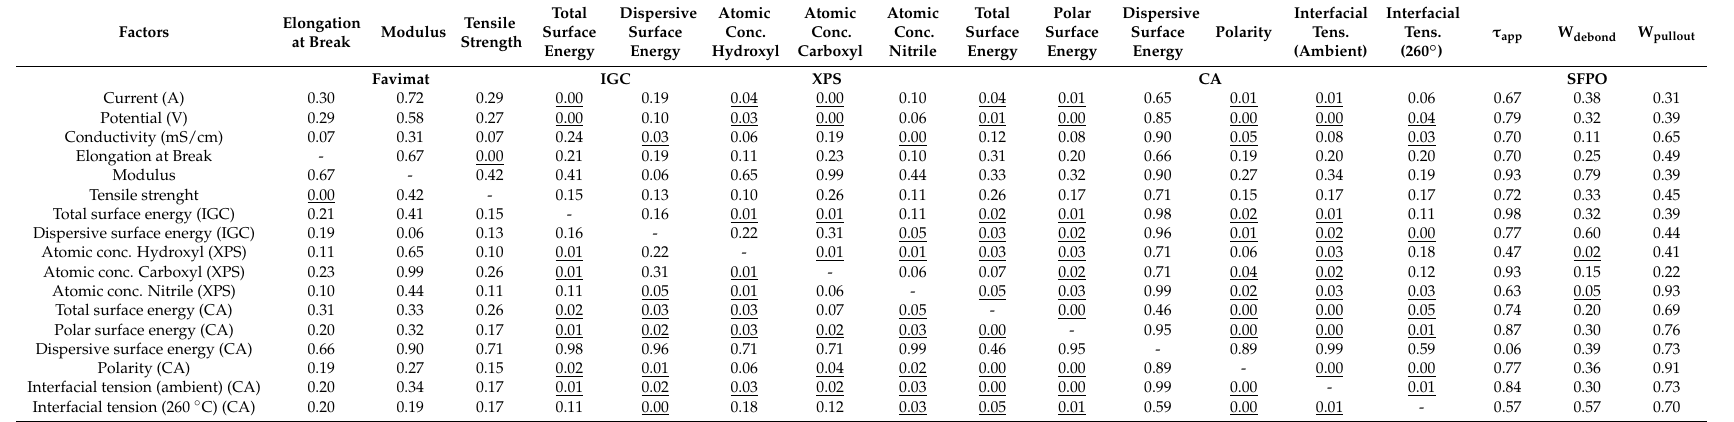
Table 9. p -values for the correlation factors on pair-wise comparisons; p -values < 0.05 are considered as significant and are underlined.